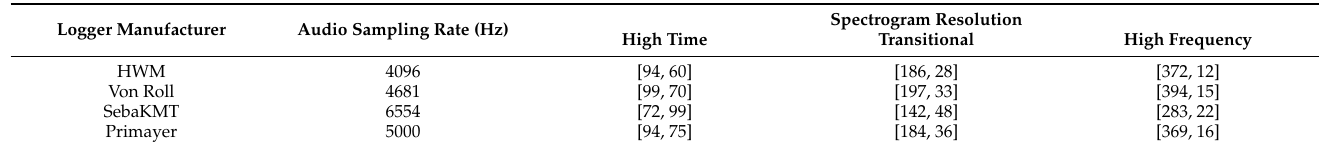
Table 2. TFCNN model spectrogram matrix sizes for different